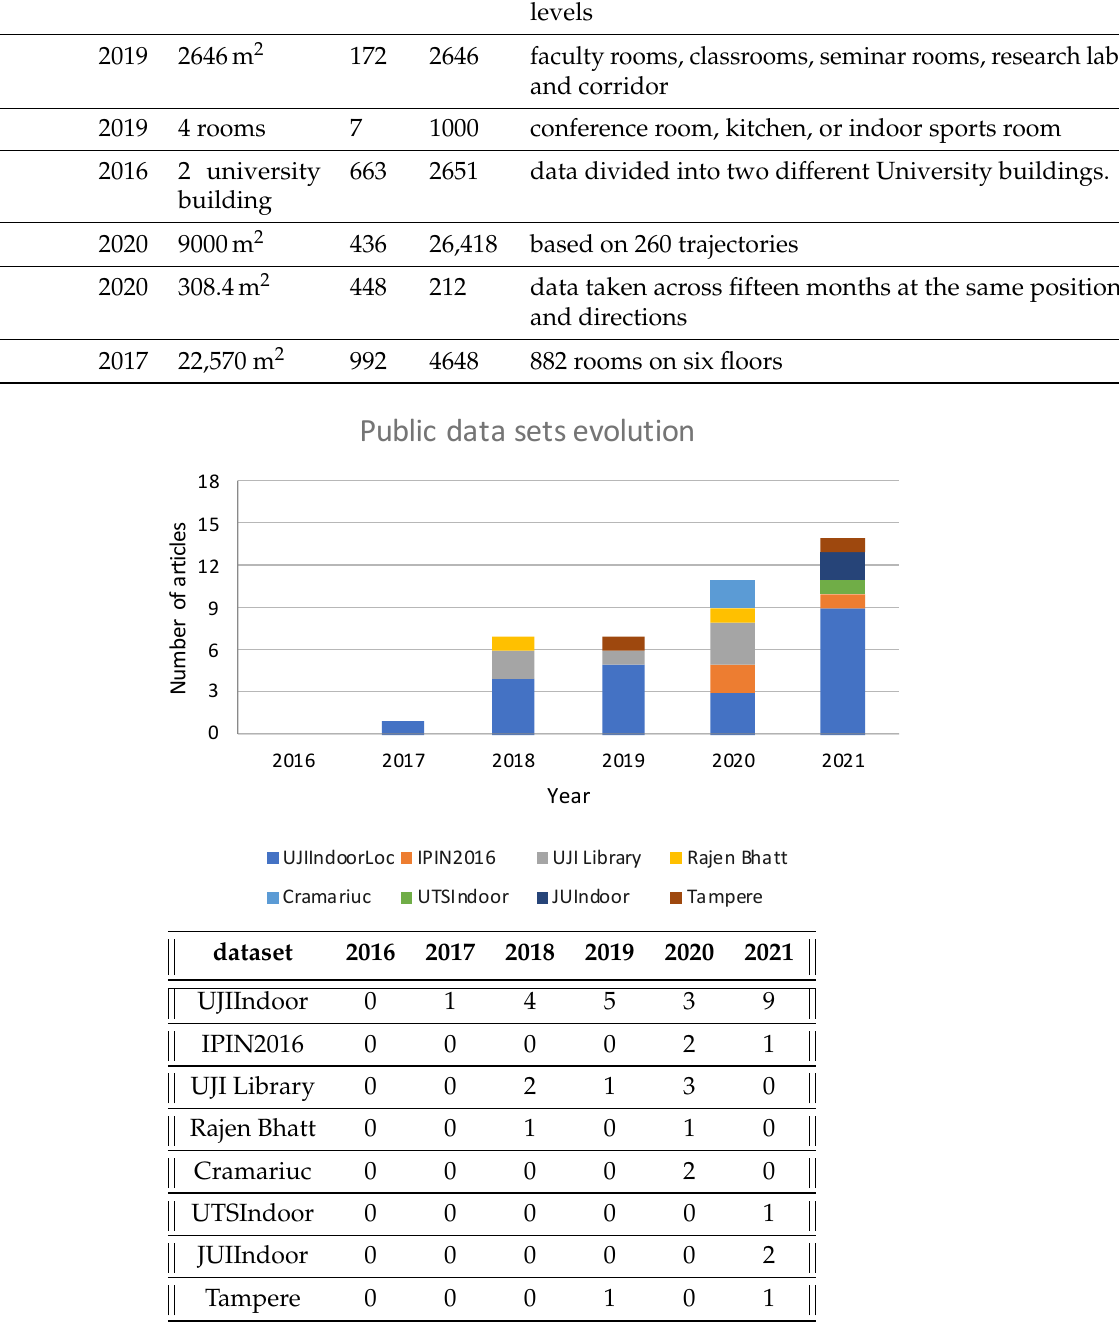
Figure 8. Evolution of the use of public datasets over the